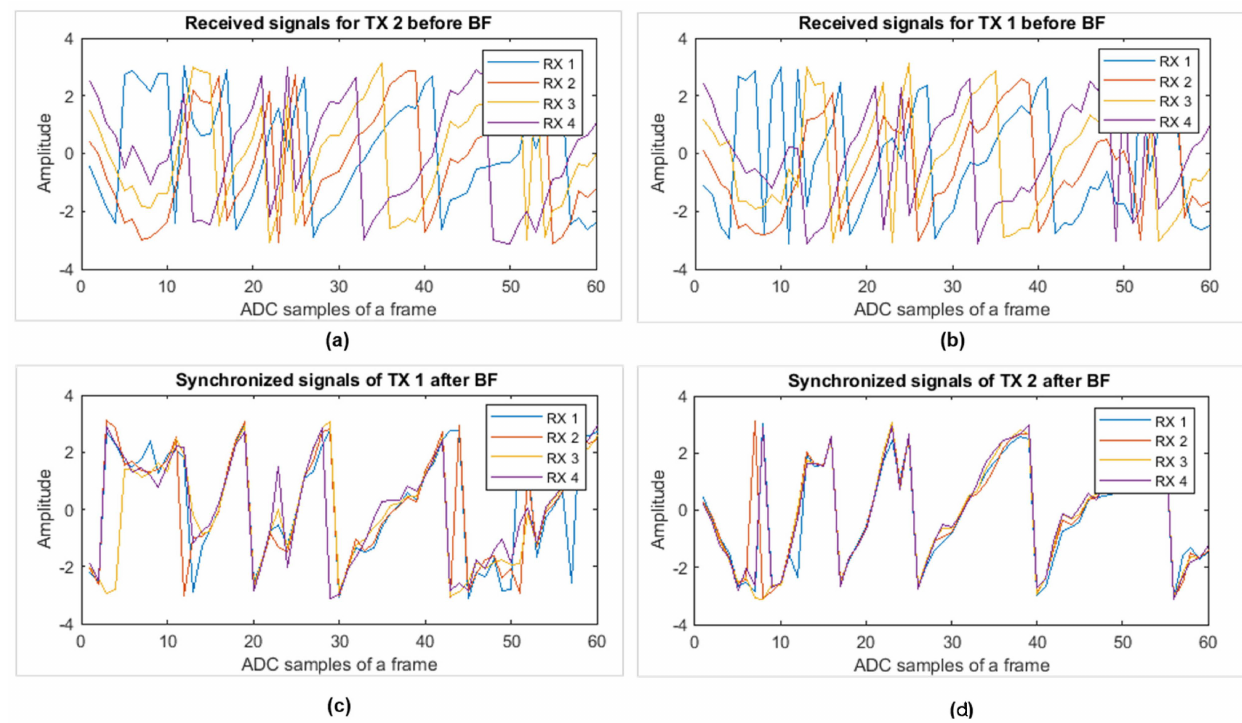
Figure 10. Phase of signal at target point: ( a ) raw data of all four RX channels corresponding to TX 1; ( b ) all RX corresponding to TX 2; ( c ) beamforming output corresponding to TX 1; and ( d ) the beamforming output corresponding to TX